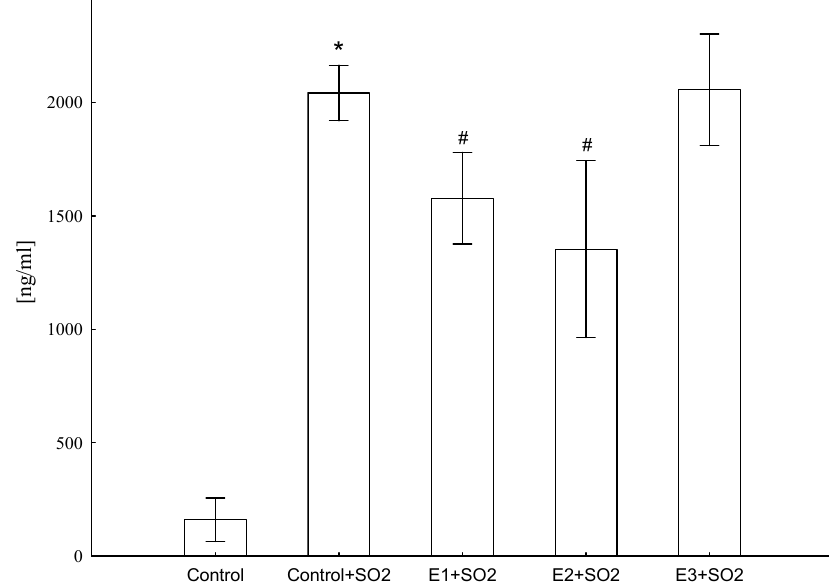
Figure 5. Influence of different extracts from Platycodon grandiflorum A. DC on CRP concentration in blood serum of rats. Values are expressed as means ± SD, *—vs. control group, p ≤ 0.05, #—vs. control group+SO 2 , p ≤ 0.05